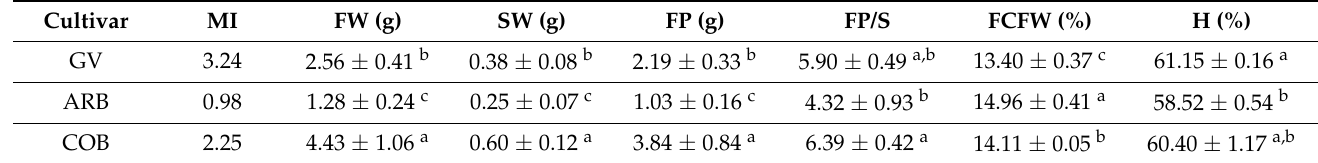
Table 1. Measurement of maturity index (MI), fruit weight (FW), stone weight (SW), fruit pulp (FP), fruit pulp to stone ratio (FP/S), fat content in fresh weight (FCFW) and humidity (H), for three olive cultivars—‘Galega vulgar’ (GV), ‘Arbequina’ (ARB) and ‘Cobrançosa’ (COB). The values represent the measurement of three assays and the associated standard